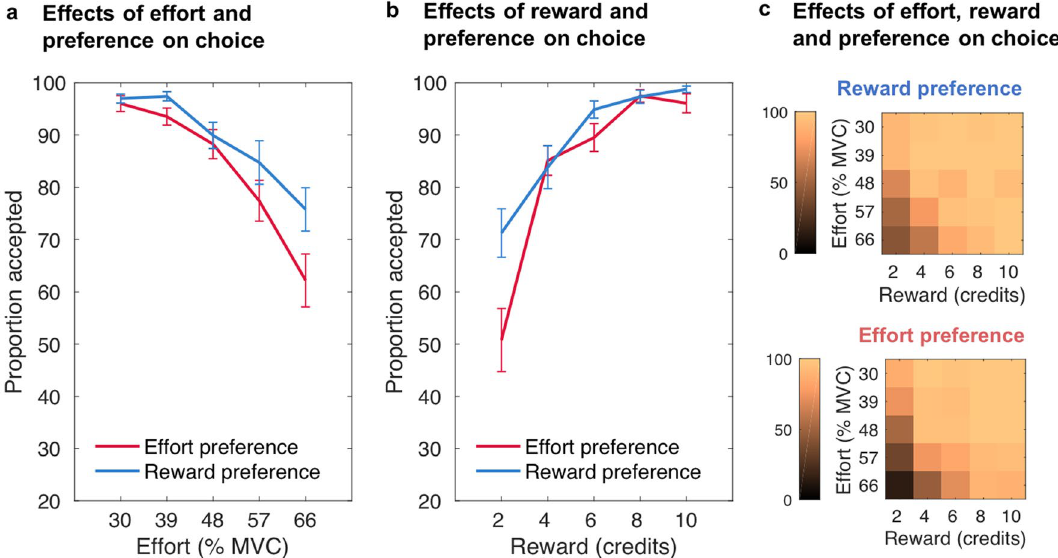
Figure 3. The willingness to exert effort on a trial depends on participants’ preferences for seeking effort information first on a trial . Mean proportion of accepted work offers as a function of preference for effort or reward information first on a given trial, dependent on ( a ) the effort level, ( b ) the reward level, and ( c ) the effort and reward levels of the work offer. Reward preference (blue) depicts choice behaviour on trials on which participants chose to first see reward information, while effort preference (red) depicts choice behaviour on trials on which participants chose to first see effort information. There was an interaction between preference and effort level on choice, indicating a reduced willingness to exert higher levels of effort for rewards if participants had chosen to see the effort required before the reward on offer. Error bars represent standard errors of the